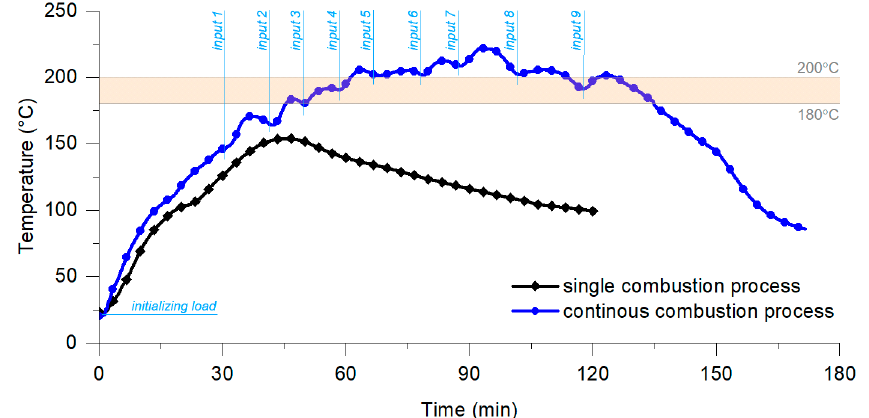
Figure 10. The variations in the thermal oil temperature at the boiler’s outlet in case of single and continuous combustion processes.